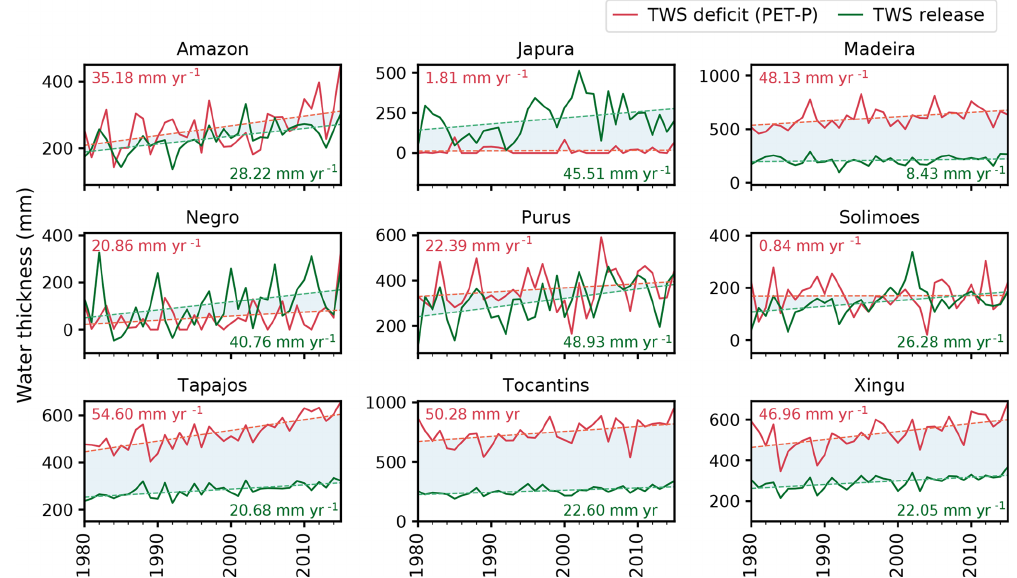
Figure 11. Trends in dry-season total deficit (TWD) quantified as the cumulative difference between potential evapotranspiration and pre- cipitation (PET-P) and corresponding simulated TWS release (TWS-R) from LHF for Amazon and its